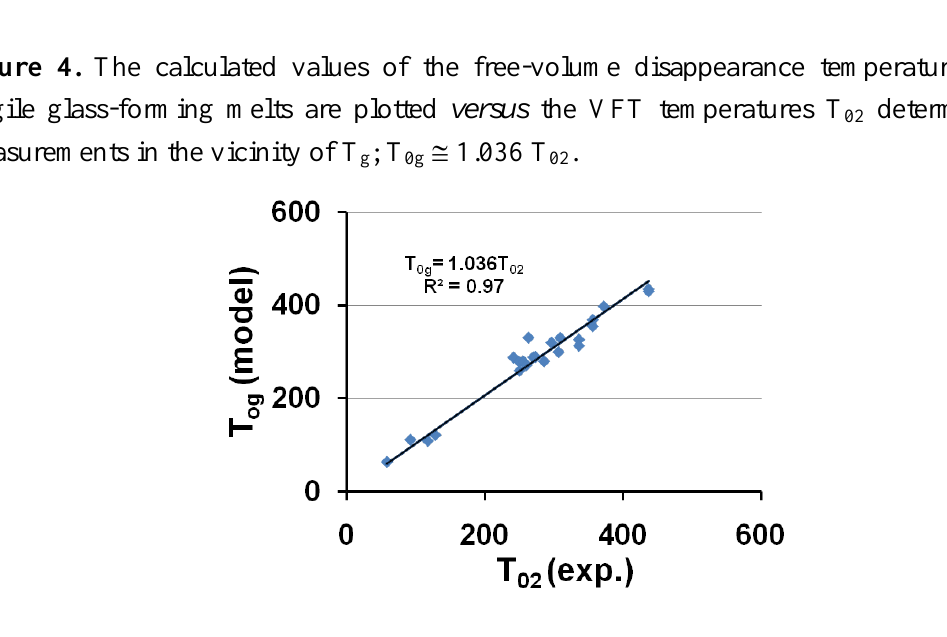
of 0g determined by 02